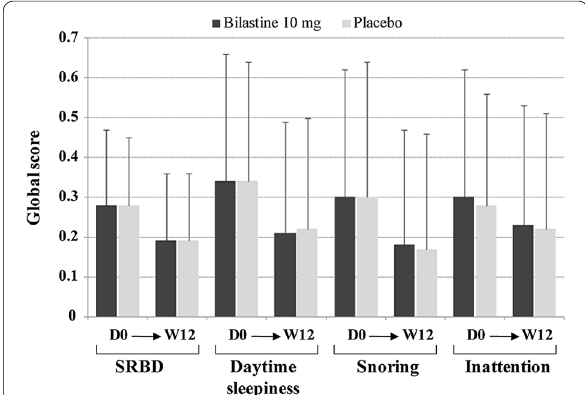
Fig. 2 Assessment of somnolence/sedation from baseline (D0) to week 12 (W12) according to global scores on the four domains of the Pediatric Sleep Questionnaire: sleeping-related breathing disorder (SRBD), daytime sleepiness, snoring and inattention (reproduced with permission from